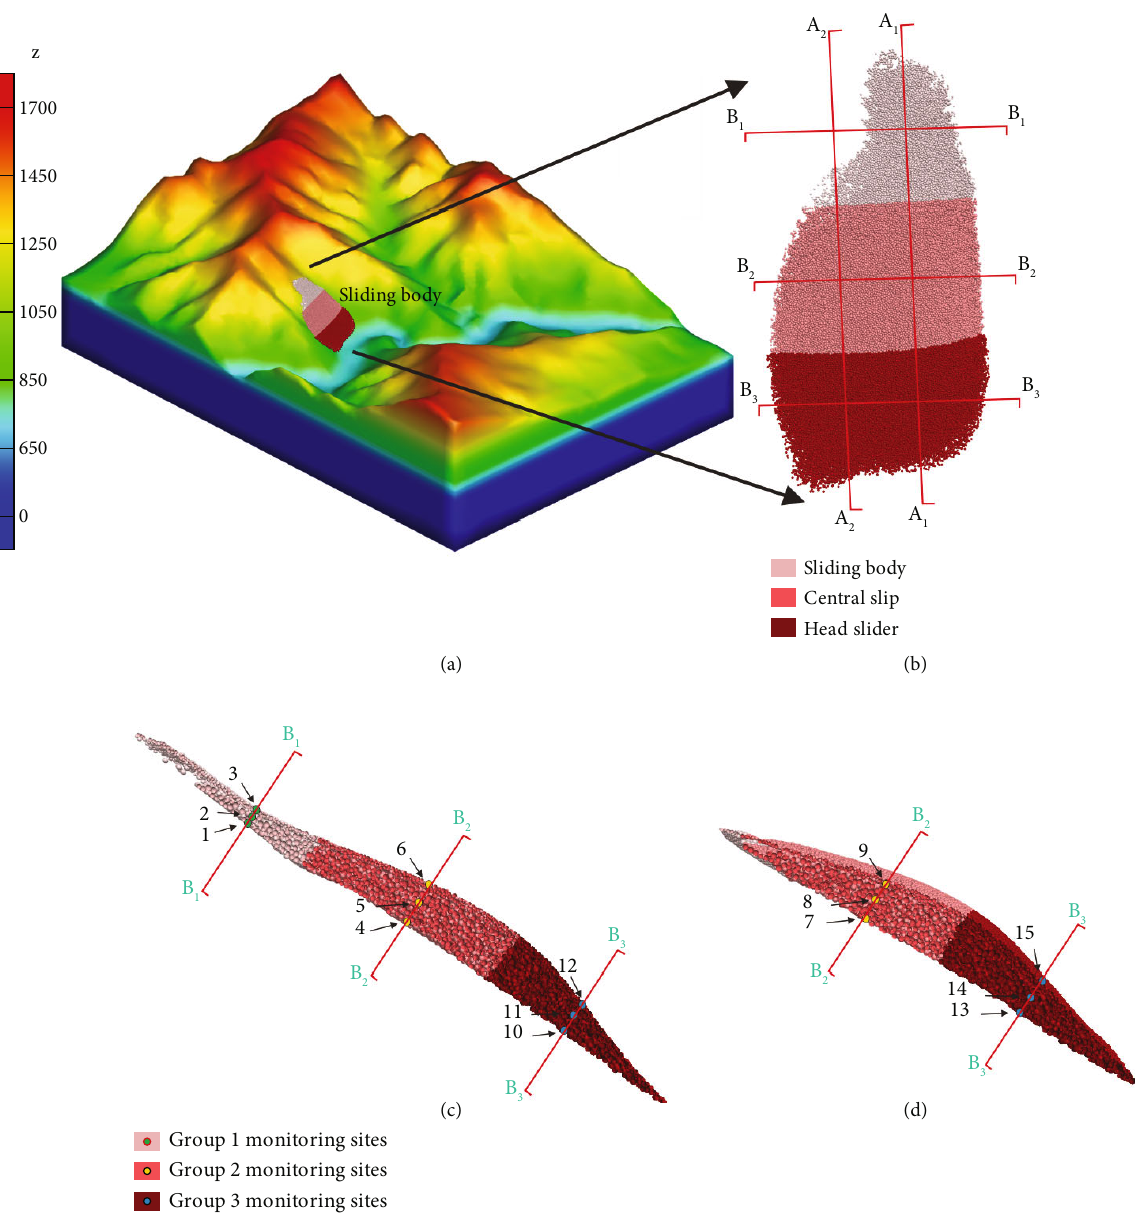
Figure 5: Slip grouping map and distribution of monitoring points. (a) Numerical simulation model diagram. (b) Distribution of slide pro fi le lines. (c) Distribution of monitoring points in pro fi le A